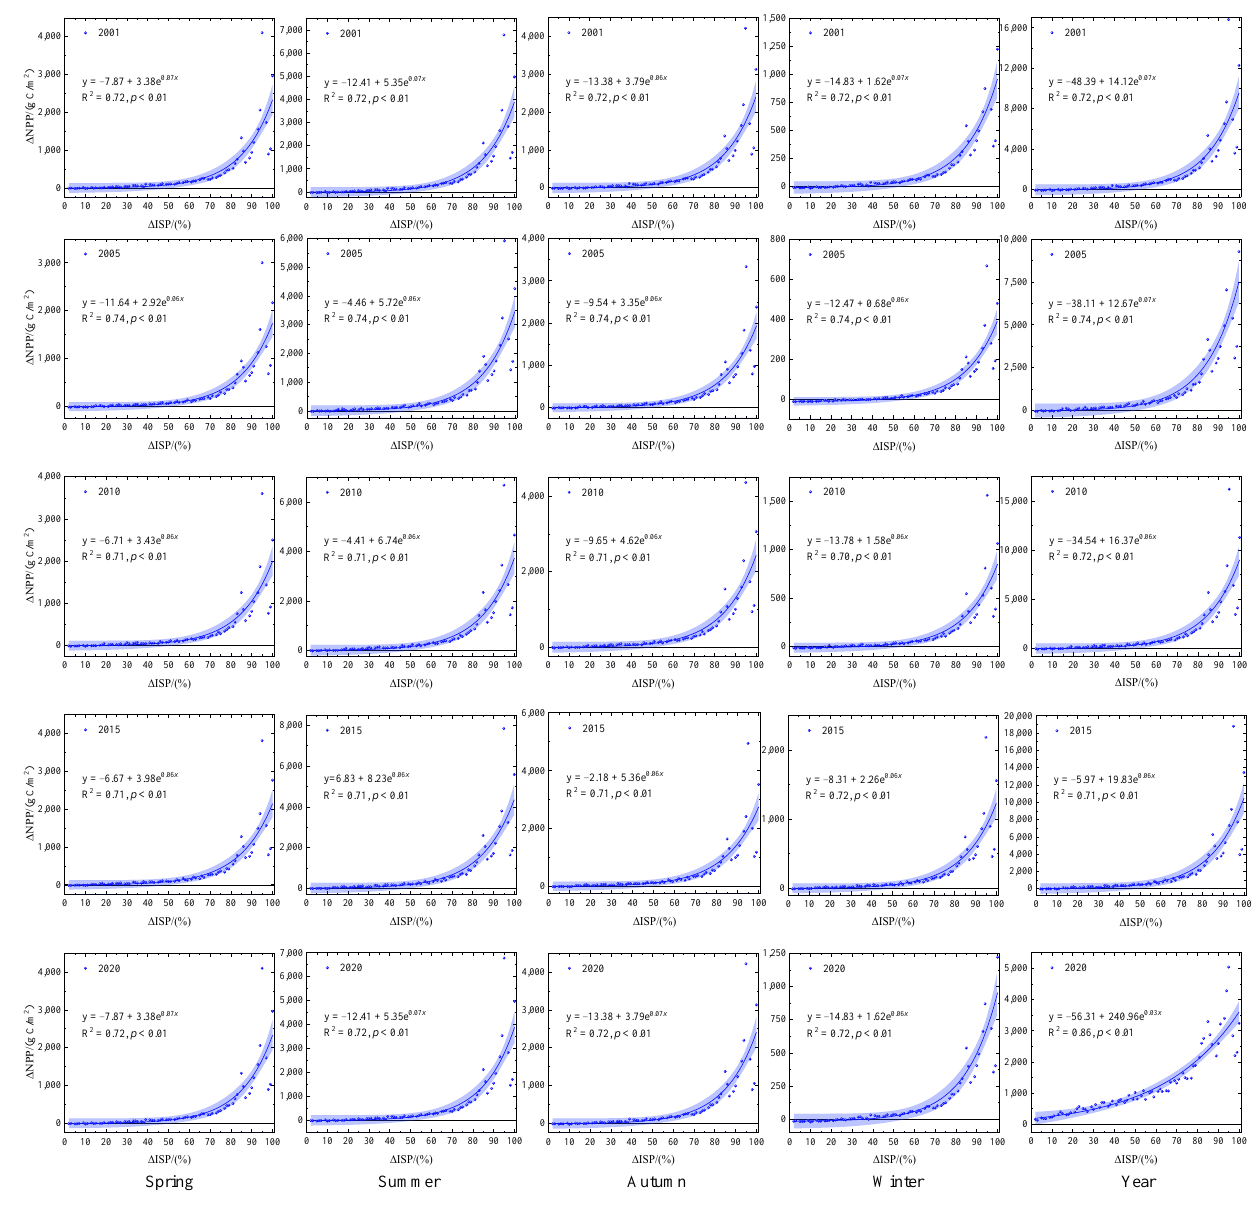
Figure 4. The indirect impact of ISP on NPP during 2001–2020. During the study period, the ISP threshold for the effect of urbanization on vegetation growth rose. The threshold effects of the ISP indirectly enhancing the urban NPP increased from 17.60% in 2001 to 0.01% in 2020, indicating that the positive indirect impact increased in the urban–rural gradient. Moreover, the ISP threshold had obvious seasonal